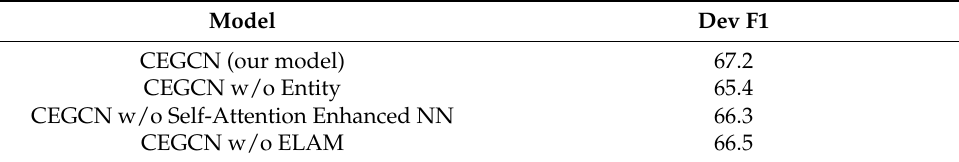
Table 4. Results on the Semeval-2010 Task 8 dataset.